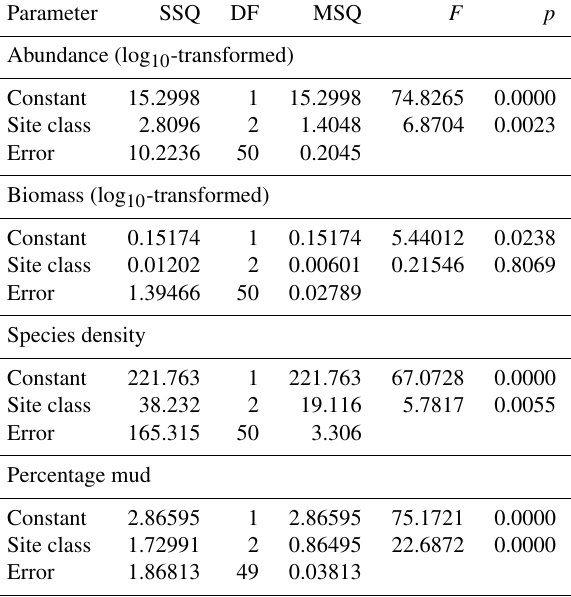
Table 1. Univariate ANOVAs for macrozoobenthos parameters ver- sus site classes (undisturbed control, disturbance > 10 years ago, disturbance during past 10 years). SSQ: sum of squares; DF: de- grees of freedom; MSQ: mean square; F : F